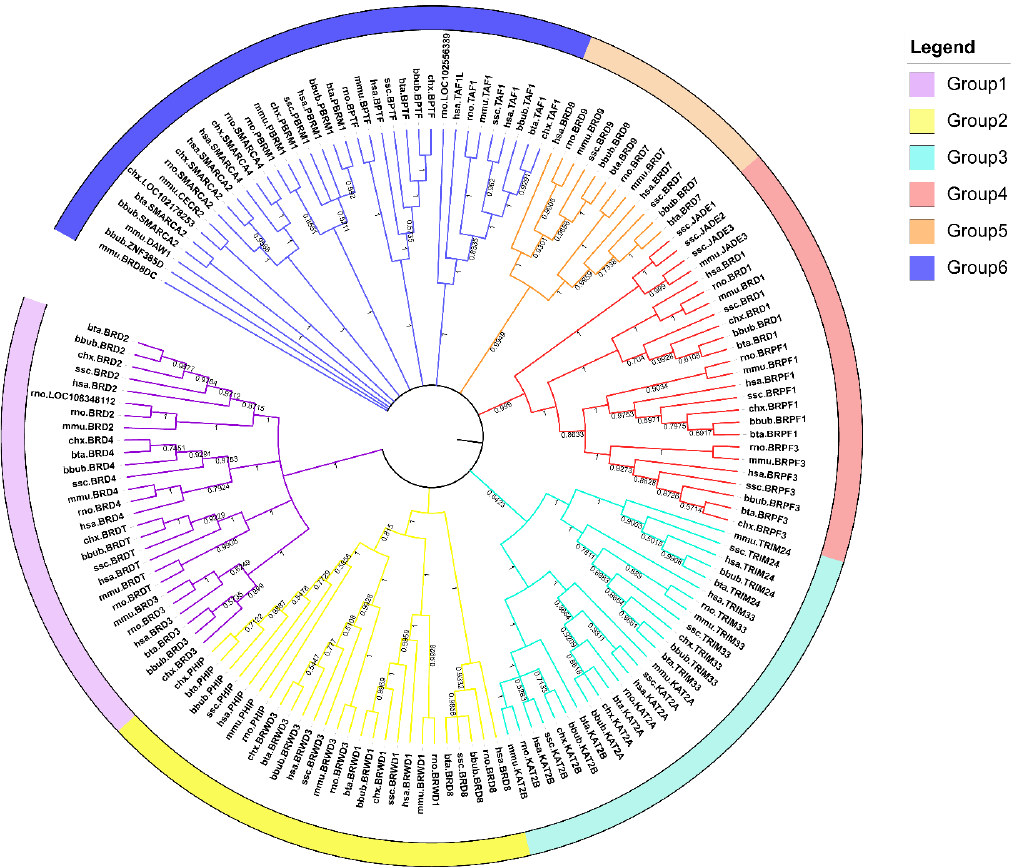
Figure 1. NJ tree of BRD proteins in seven mammals. Different-colored clades and strips indicate different groups. Note: buffalo: bbub; mouse: mmu; rat: rno; human: hsa; goat: chx; cow: bta; pig: ssc.